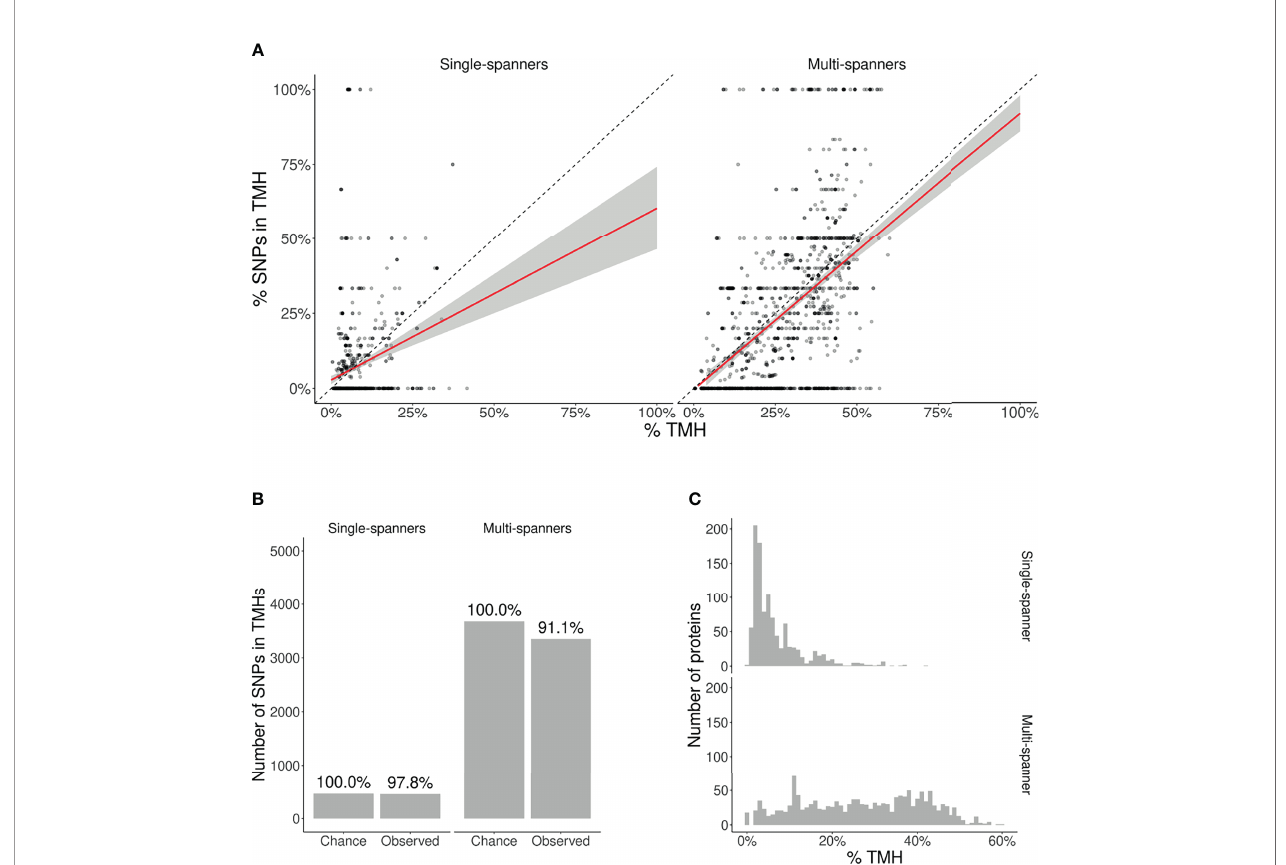
FIGURE 4 | | Membrane proteins with multiple TMHs are evolutionary more conserved than proteins with only a single TMH. (A) Percentage of SNPs found in TMPs predicted to have only a single (left) or multiple (right) TMHs. Each point shows for one protein the predicted percentage of amino acids that are part of a TMH ( x - axis) and the observed occurrence of SNPs being located within a TMH ( y -axis). The dashed diagonal lines show the line of equality (i.e., equal conservation of TMHs and soluble protein regions). The diagonal red lines indicate a linear fi t, the gray areas their 95% con fi dence intervals. (B) The number of SNPs in TMHs as expected by chance and observed in the dbSNP database, for TMPs with one TMH (single-spanners) and multiple TMHs (multi-spanners). Percentages show the relative conservation of SNPs in TMHs found relative to the stochastic chances. (C) Distribution of the proportion of amino acids residing in the plasma